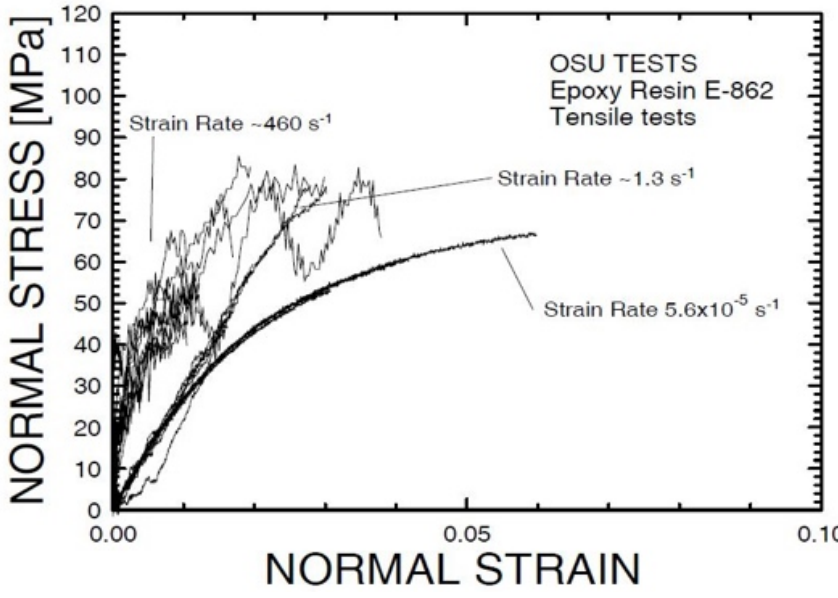
Figure 10. Normal stress-strain curve of Epoxy resin E − 862. The values of unidirectional E-8962 are reported in the Table 3. Table 3. Material properties of Carbon fiber E-862 unidirectional tape.